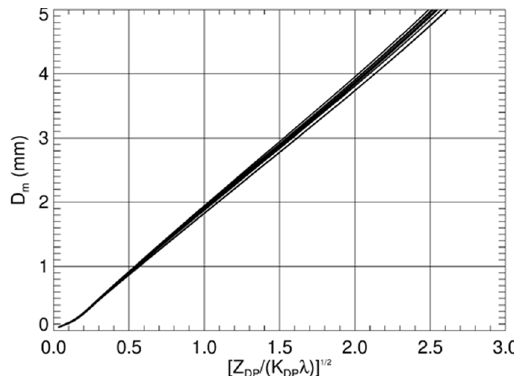
Figure 14. Dependence of the mean volume diameter (D m ) of ice particles on [Z DP / (K DP λ )] 1 / 2 for various ice habits for exponential size distribution ( µ = 0) and the factor α in (15) equal to 0.2. From Ryzhkov and Zrnic [3]. Used with permission from Springer.